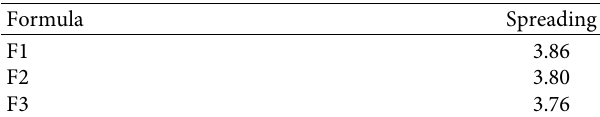
Table 2: Dispersion test on the